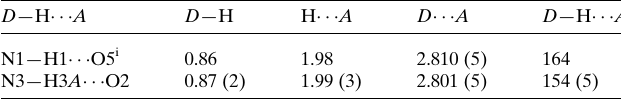
Table 1 Hydrogen-bond geometry (A˚ , (cid:4) ) for ( 2 ).